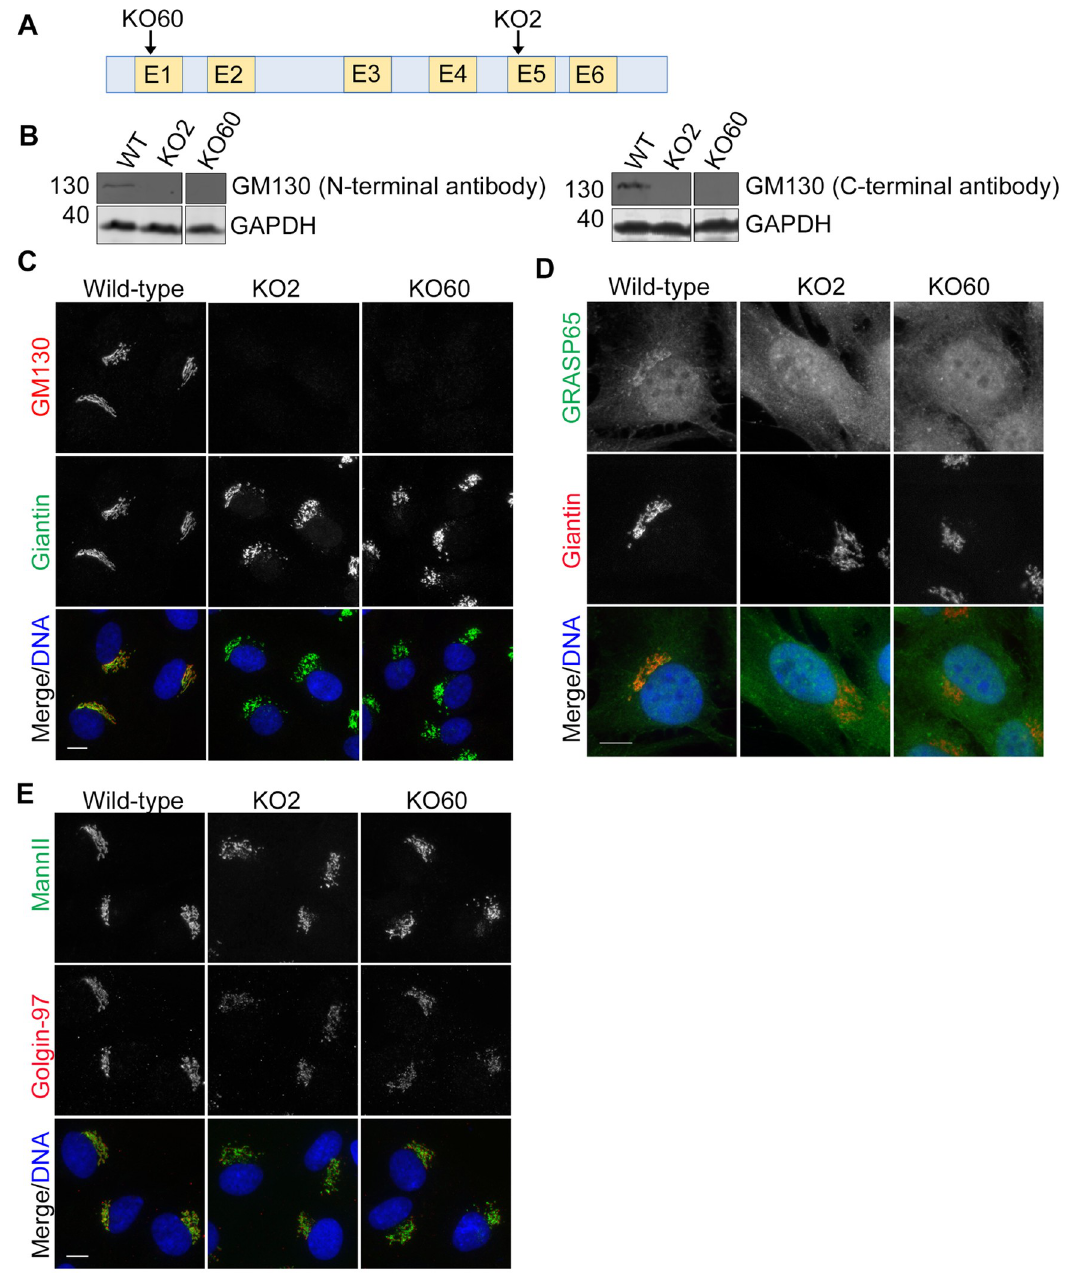
Fig 1. GM130 is required for normal Golgi organization in RPE-1 cells. A . Clonal GM130 knockout (KO) cell lines were generated by targeting Cas9 to exon 1 (KO60) or exon 5 (KO2) of GOLGA2 , the gene encoding for GM130. B . Western blotting with an antibody to the GM130 N-terminus (left panel) or C-terminus (right panel). GAPDH served as a loading control. C—E . Wild- type and GM130 KO cells were analyzed by immunofluorescence microscopy with antibodies to GM130 and Giantin ( C .) GRASP65 and Giantin ( D .) and Mannosidase II and Golgin-97 ( E .). For each panel, merged images are also shown in which DNA is stained with DAPI. Scale 10 μ m.